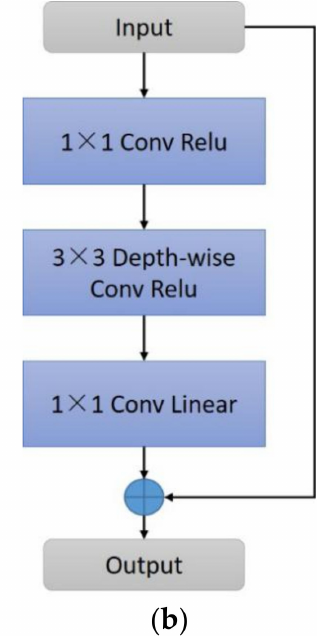
Figure 3. The structure of our encoder and inverted residual block. ( a ) Structure of encoder; ( b ) the processing flow of the inverted residual